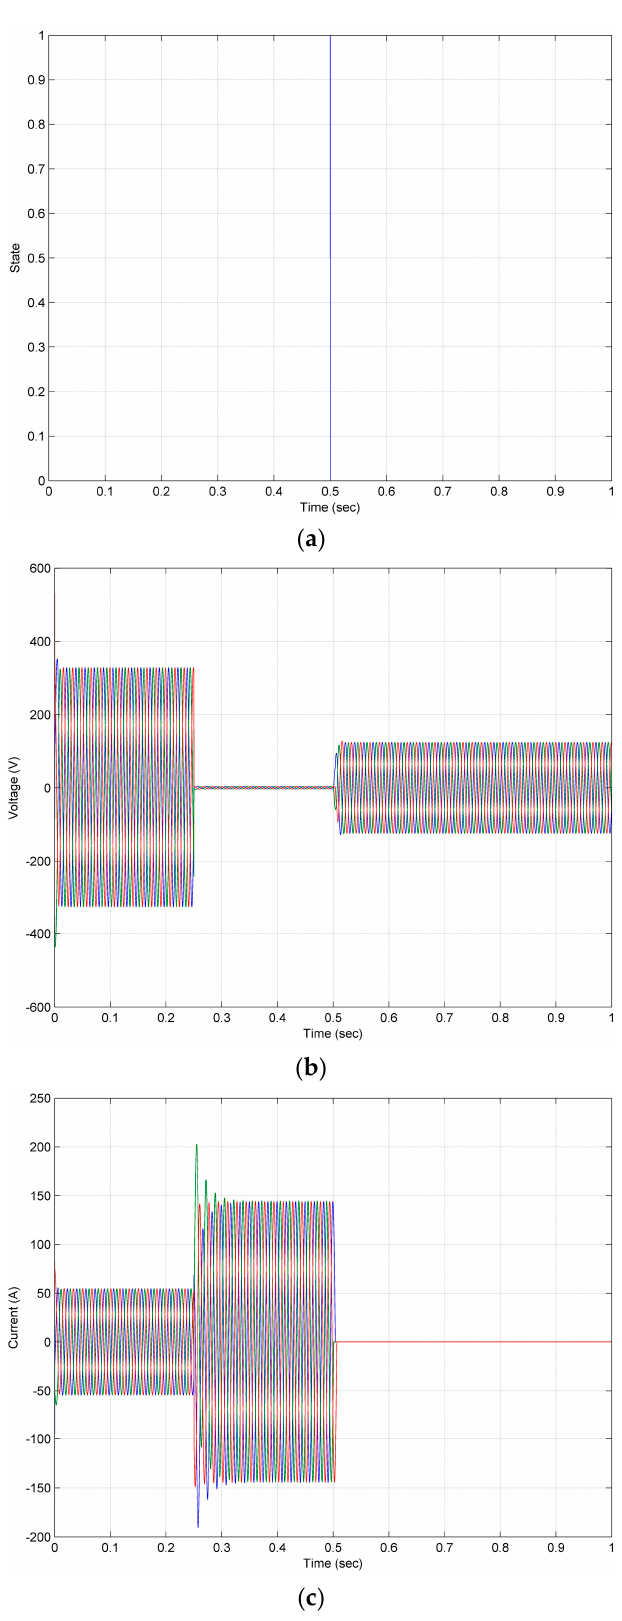
Figure 17. ( a ) CB15 CLOSE/TRIP state; ( b ) Feeder voltage waveforms of CB15 under islanded mode and fault occurrence at Bus 2; ( c ) Feeder current waveforms of CB15 under islanded mode and fault occurrence at Bus 2.